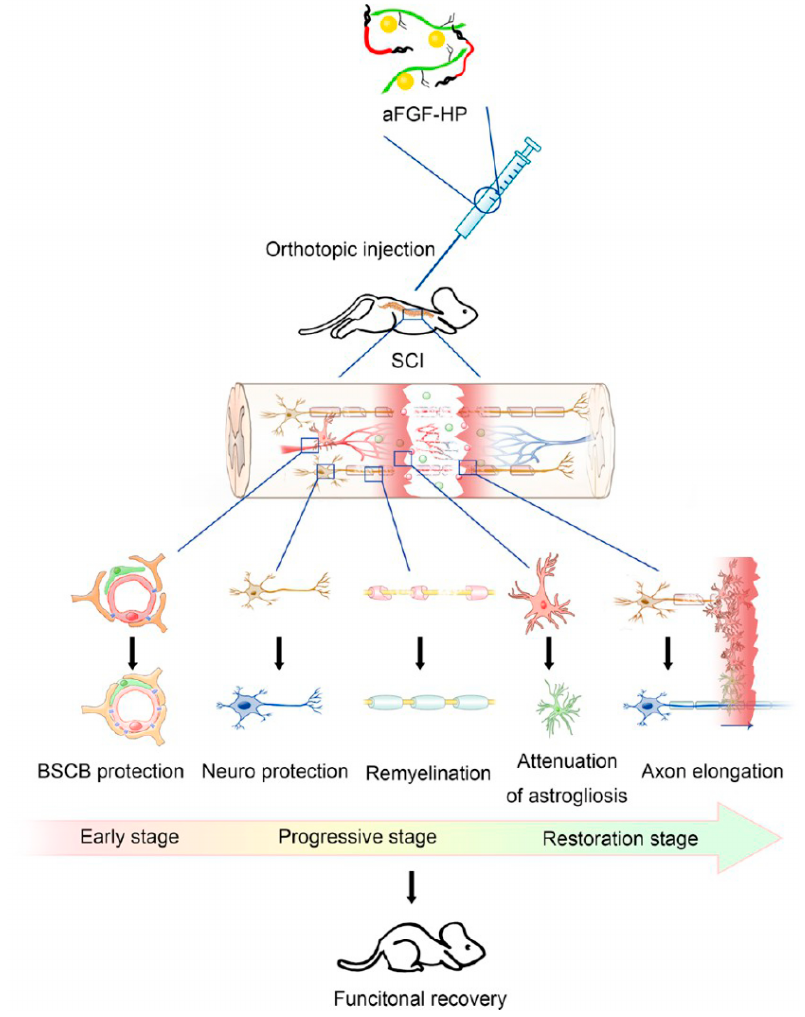
Figure 9. Schematic of aFGF-heparin (HP) thermo-sensitive hydrogels enhance the recovery of spinal cord injury (SCI). The protection of aFGF-HP containing blood-spinal cord barrier (BSCB) protection, neuroprotection, remyelination, attenuation of astrogliosis, axon elongation in three different stages after SCI, which are the main obstacles to recovery of SCI. (Reprinted with permission from reference [50]. Copyright 2017 American Chemical Society).